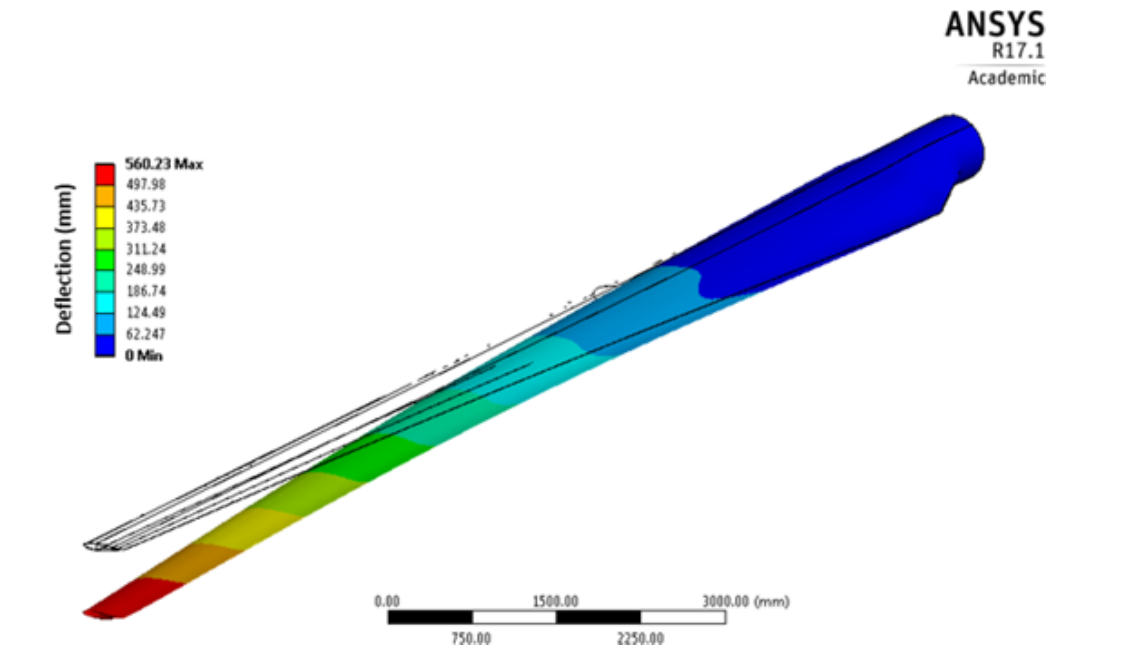
Figure 11. Deflection of the FEA model of the full-scale wind turbine blade under the defined loading.